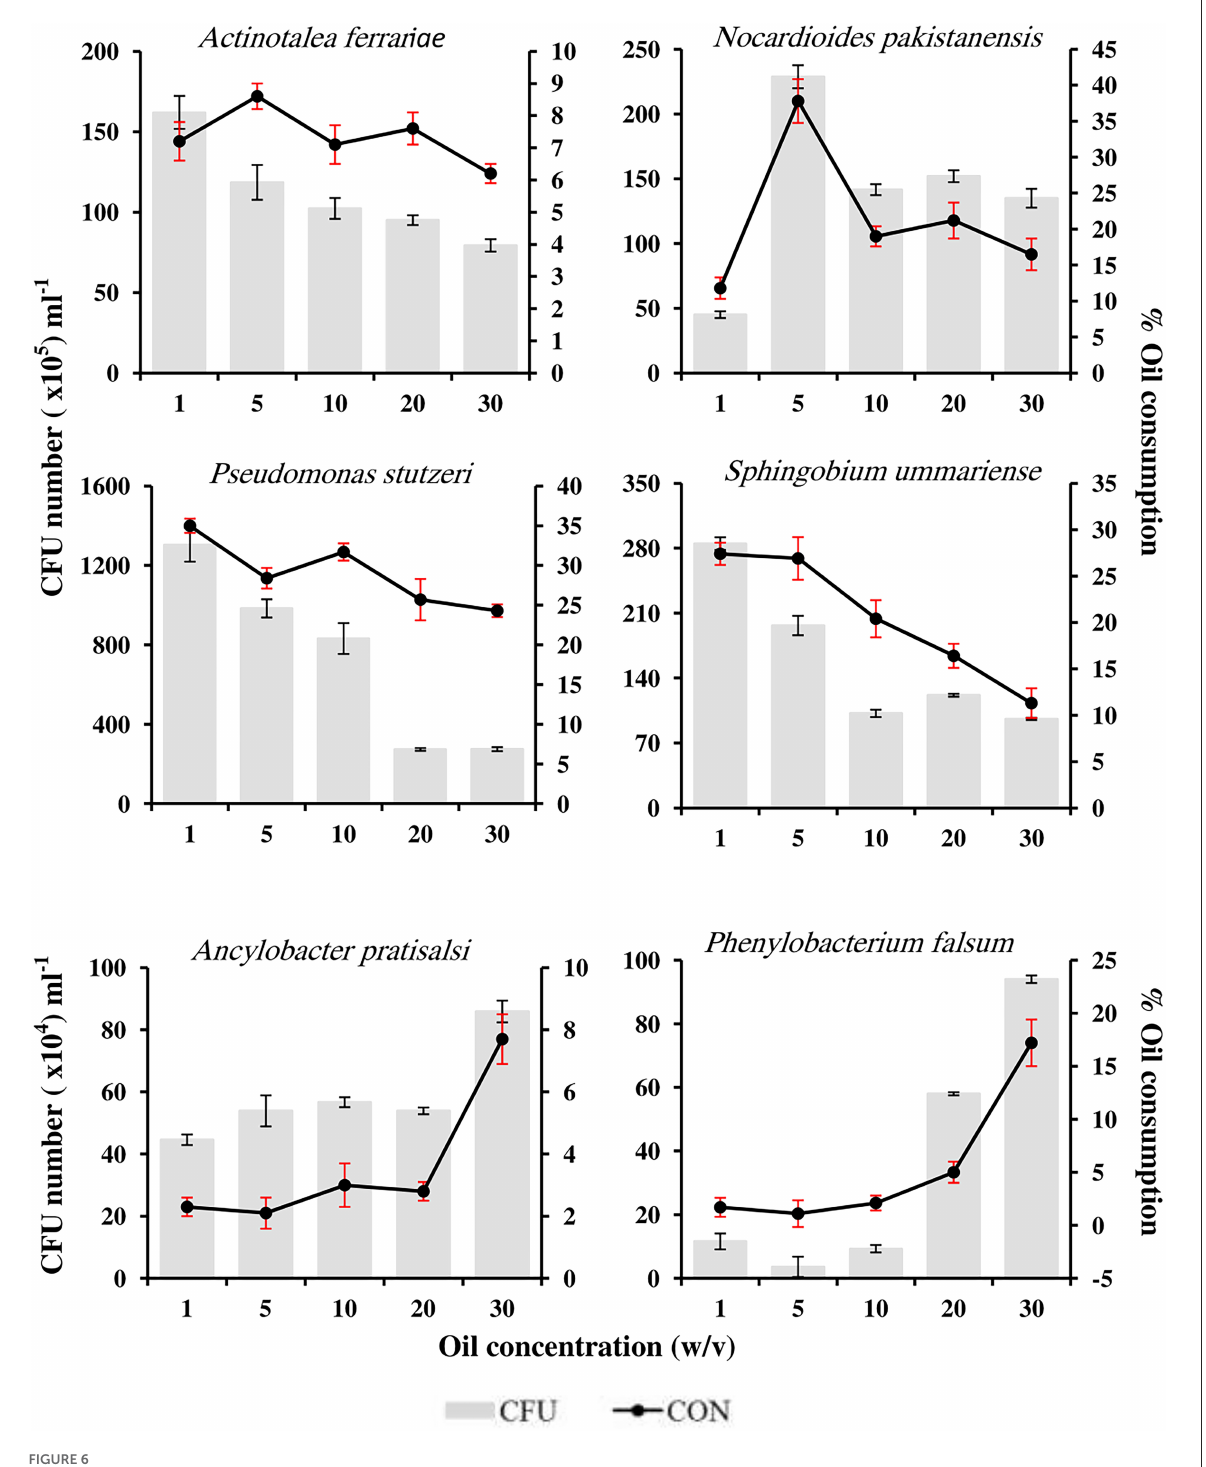
FIGURE6 Oil tolerance of six hydrocarbonoclastic